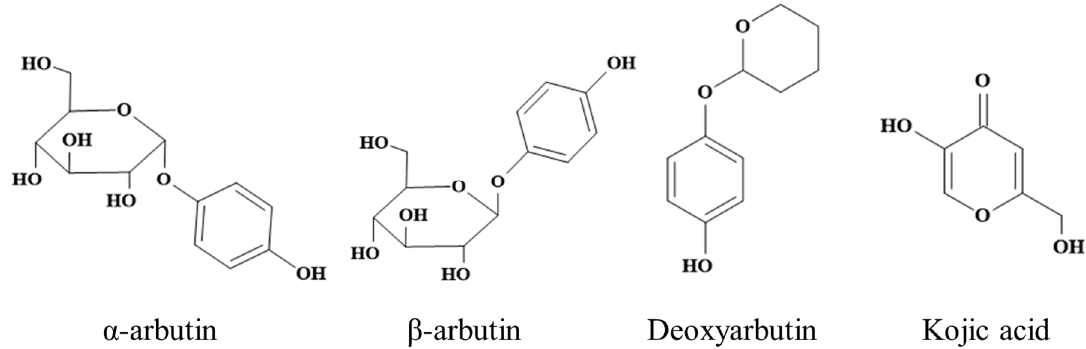
Figure 1. Chemical structure of α -arbutin, β -arbutin, deoxyarbutin, and kojic acid.